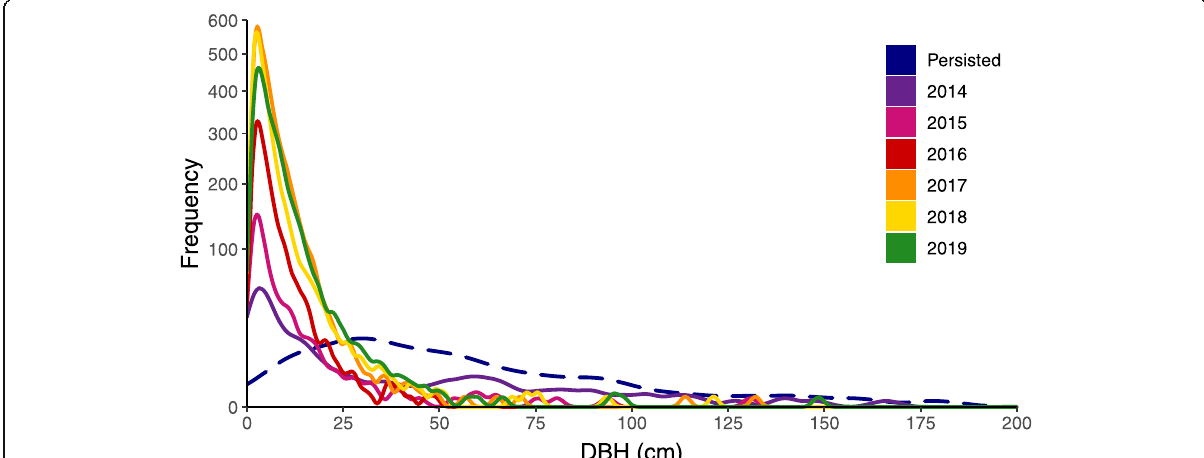
Fig. 5 Diameter distribution of each piece of fallen trees (remaining stump < 1.37 m high) from 2014 – 2019 in the Yosemite Forest Dynamics Plot, as well as the post-fire diameter distribution of those pieces that persisted through the Rim Fire. Trees < 10 cm DBH were considered to have fallen as a single piece; wood from trees ≥ 10 cm DBH was mapped explicitly by piece. Colors correspond to those in Fig. 1. Curves are based on the raw diameters smoothed with a Gaussian density kernel. The square-root transformation of the y -axis shows the low frequency but cumulative effects of large-diameter inputs